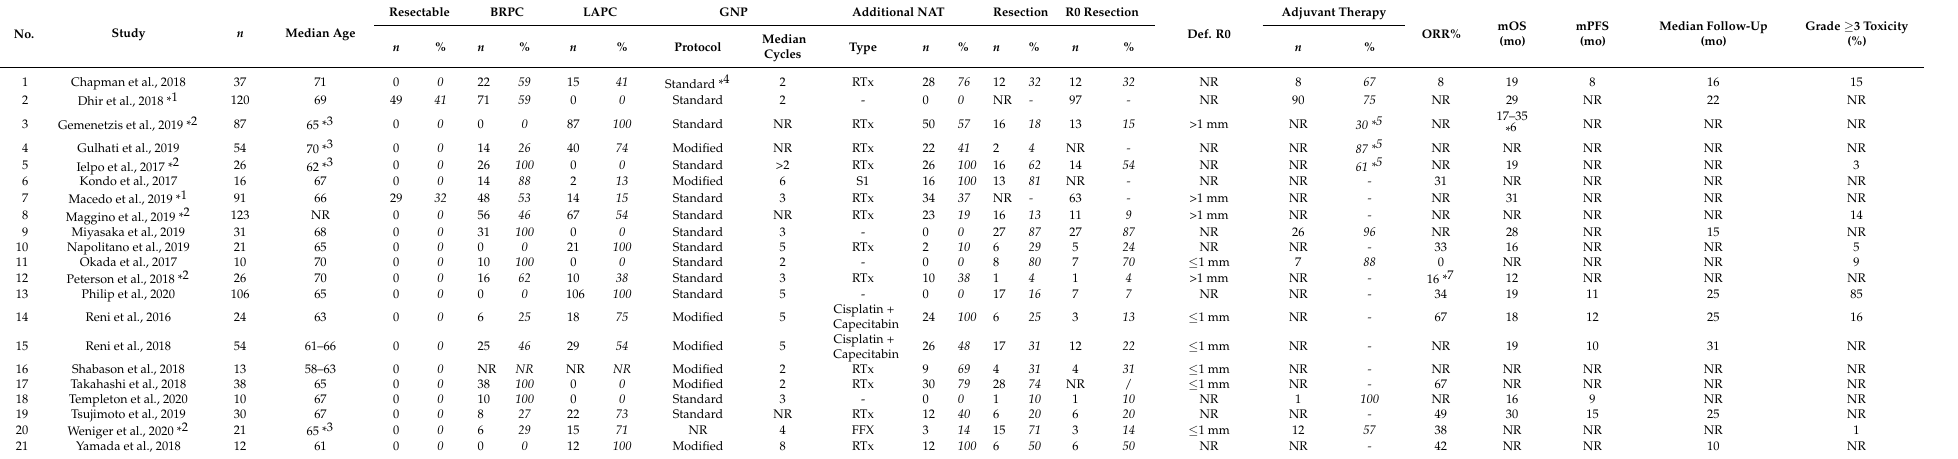
Table 2. Characteristics and outcomes of patients with neoadjuvant GNP